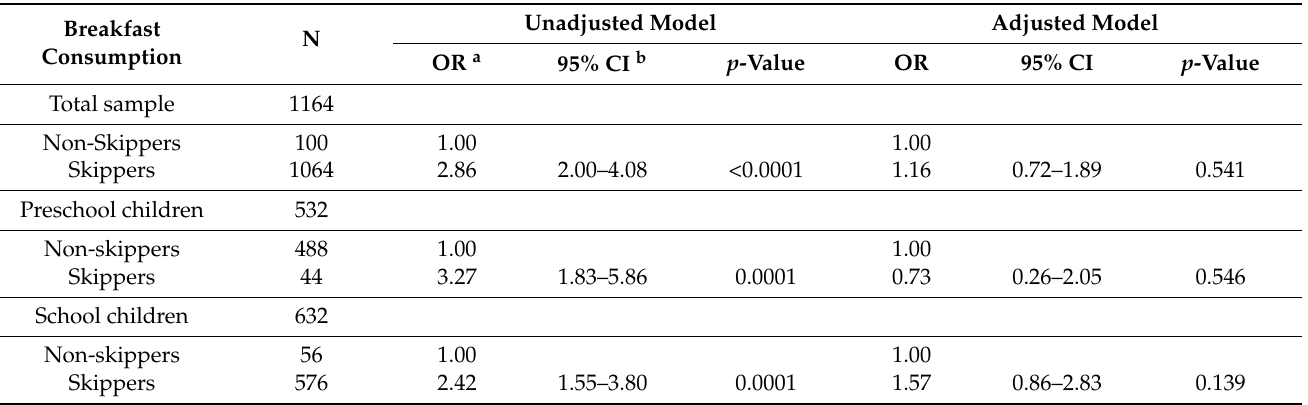
Table 4. Logistic regression analysis of the association between skipping breakfast and being over- weight or